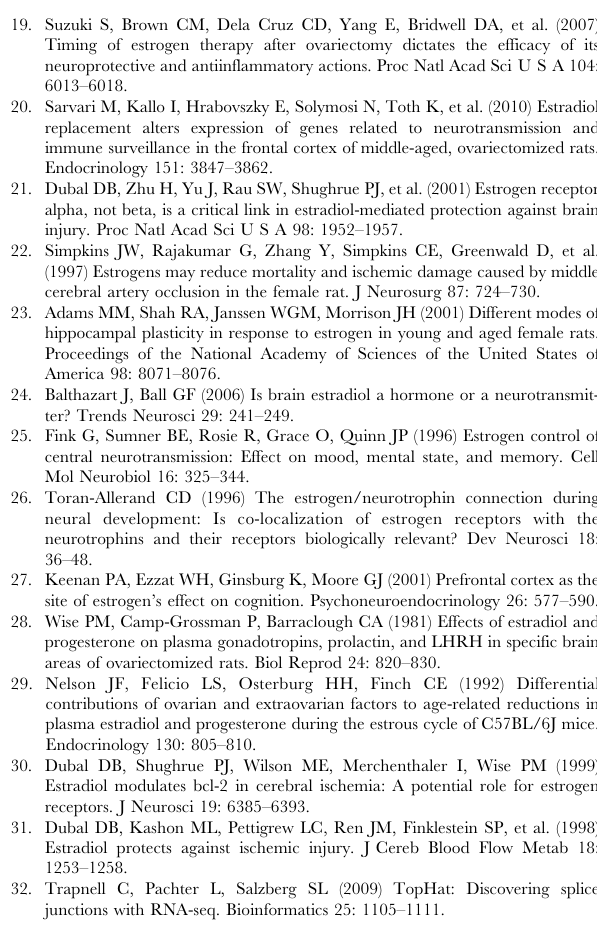
Table S1 88 E2-responsive genes in the cerebral